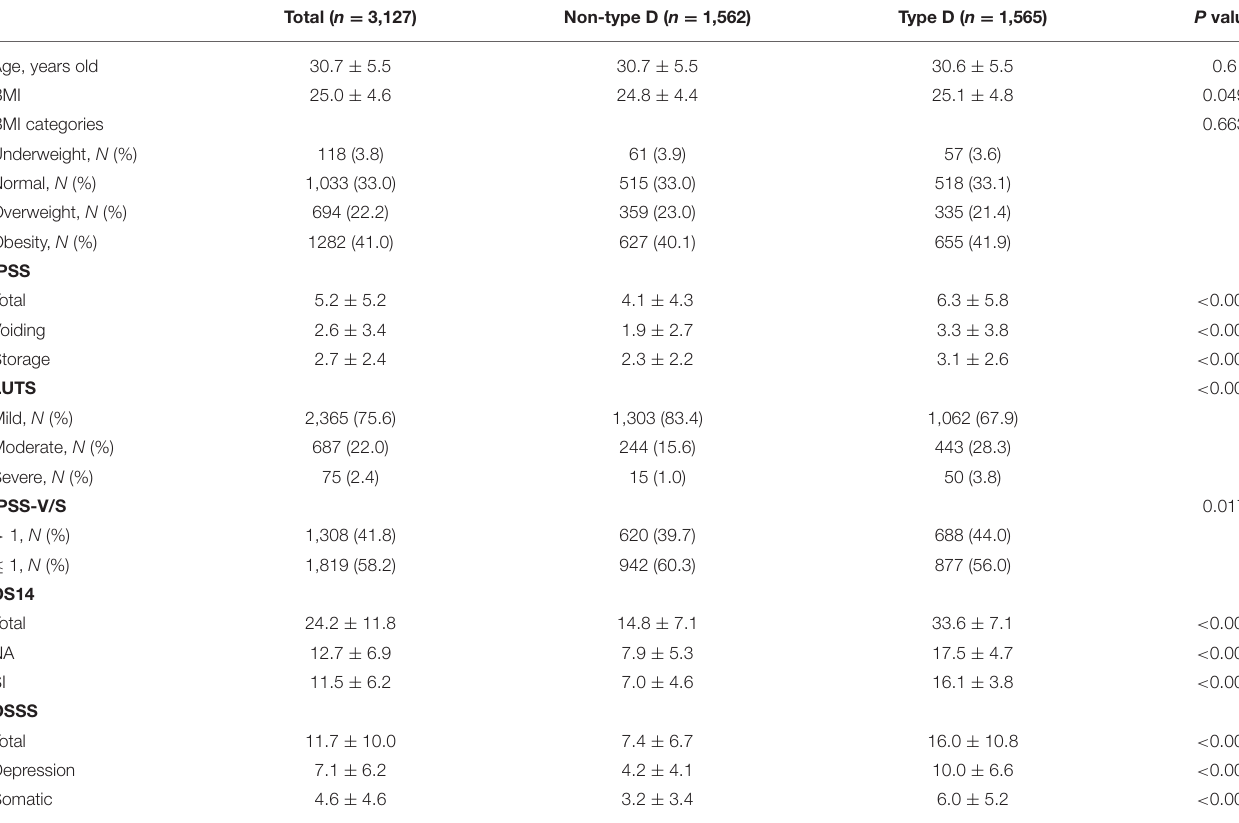
TABLE 1 | Demographic description and questionnaire survey of the study